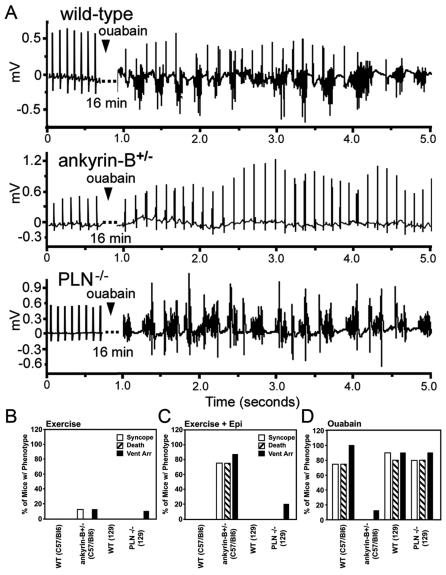
Ankyrin-B+/− mice are resistant to ouabain-induced ventricular arrhythmia and death.Wild-type (n = 8) and ankyrin-B+/− mice (n = 8), and wild-type (n = 10) and phospholamban-null mice (n = 10) were surgically-implanted with radiotelemetry ECG probes. Mice were injected with a high dose (10 mg/kg) of ouabain or 2 mg/kg epinephrine, and conscious ECGs were recorded. Unlike wild-type or phospholamban-null mice, ankyrin-B+/− mice display resistance to ouabain-induced ventricular arrhythmia (1/8) and death (0/8). Panel A represents ECG data from wild-type, ankyrin-B+/−, and PLN null mice treated with ouabain. Data in panels B–D represent summary syncope, death, and arrhythmia data for mice following exercise (panel B), exercise plus epinephrine injection (panel C), and ouabain injection (panel D).